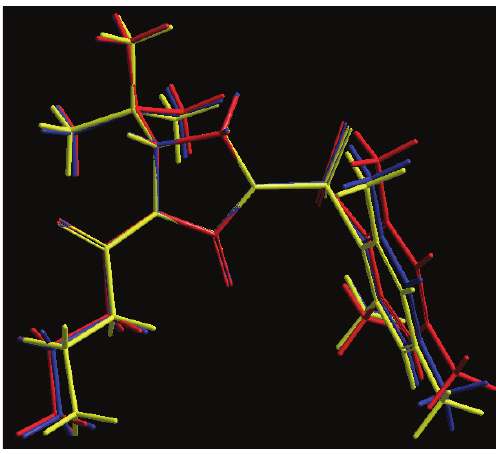
Figure 2: The superposition of the three molecules (molecule 3A : colors blue, molecule 3B : colors yellow, and molecule 3C : colors red) of X-ray structure of compound 3 .